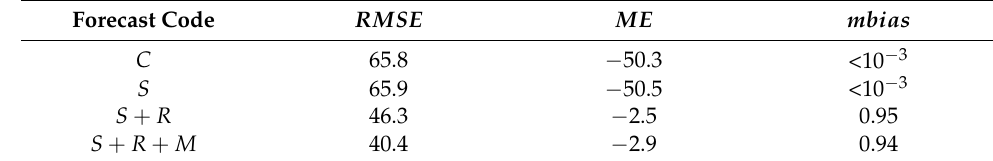
Table 4. Verification scores, as defined in Equations (8)–(10), for the four experimental runs. Forecast Code